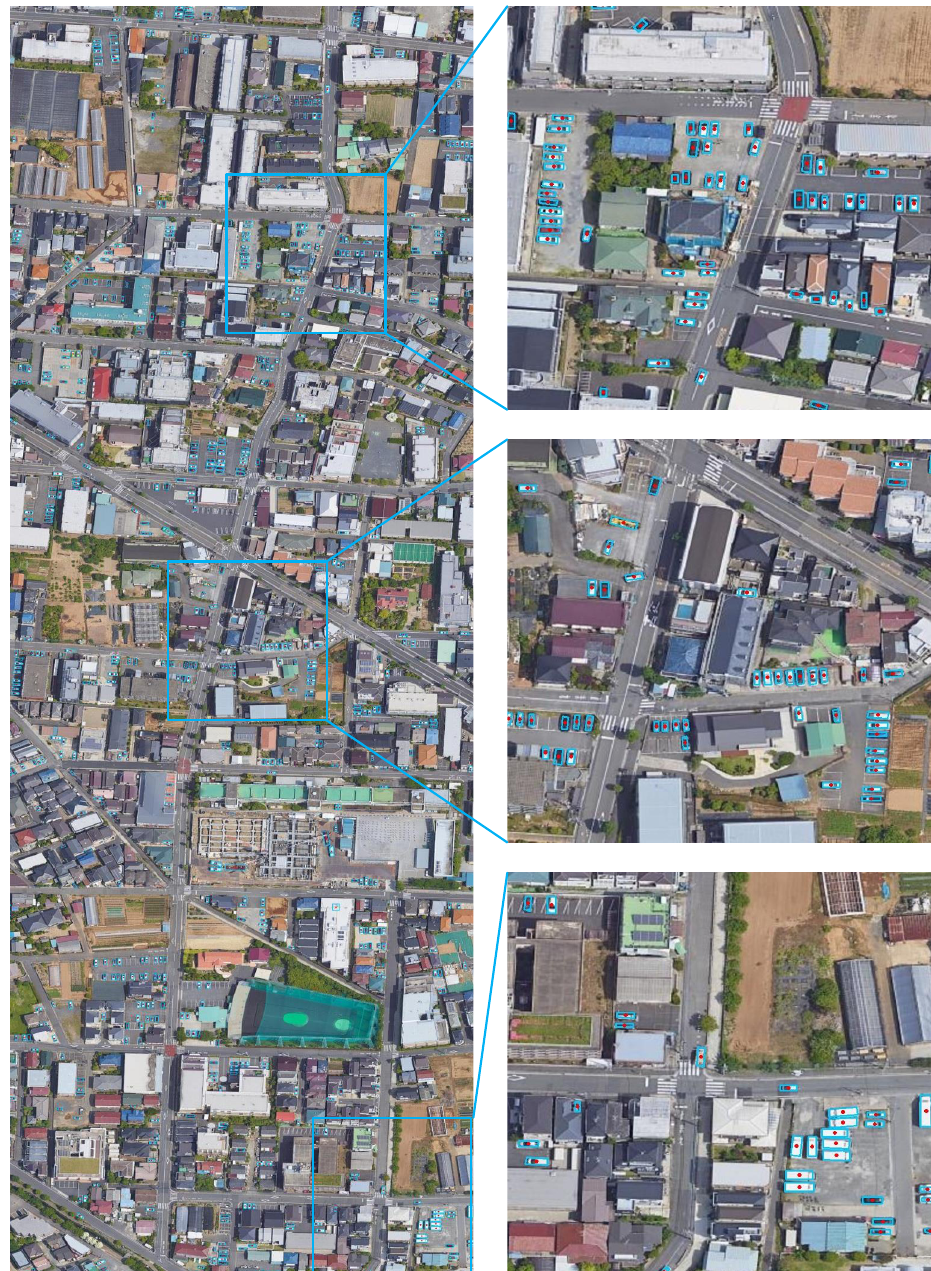
Figure 12. In order to verify the robustness of the model, we took a remote sensing panorama from Google Maps, and the selected region contains several scenes, such as densely parked parking lots, intersections, streets, private garages, etc. We used SR-Net to perform the detection, and this figure shows the detection results. It is best when viewed zoomed